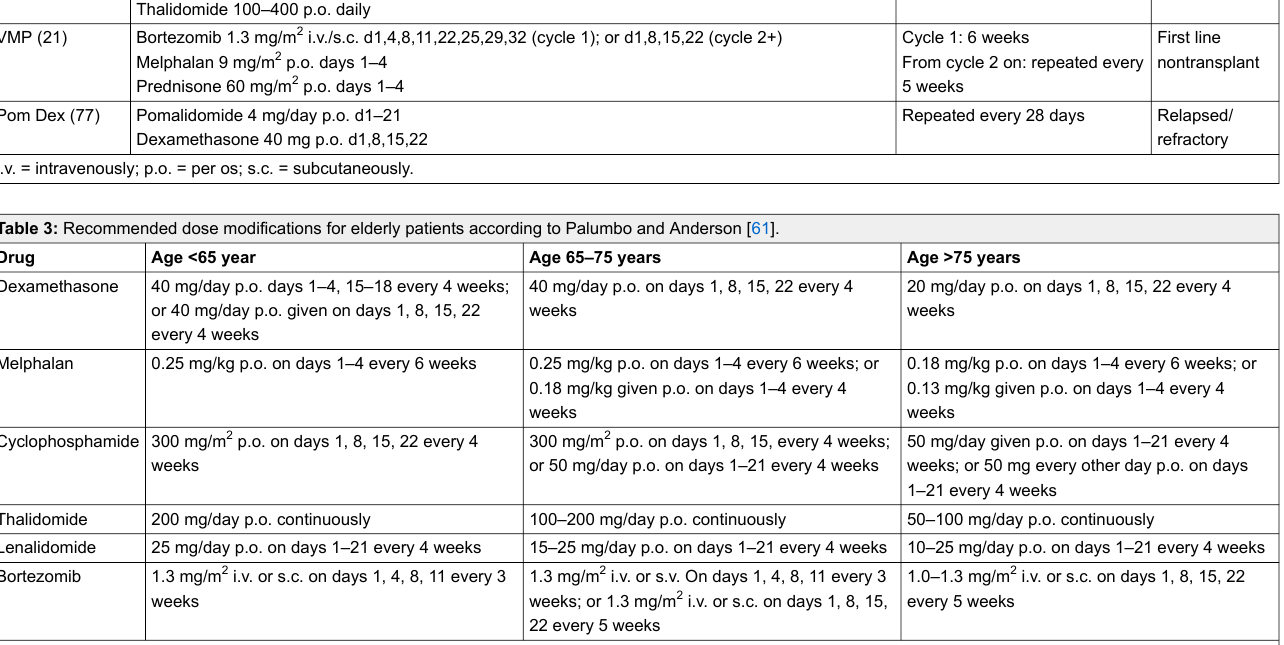
Pretransplant; reinduction before salvage ASCT pretransplant nontransplant